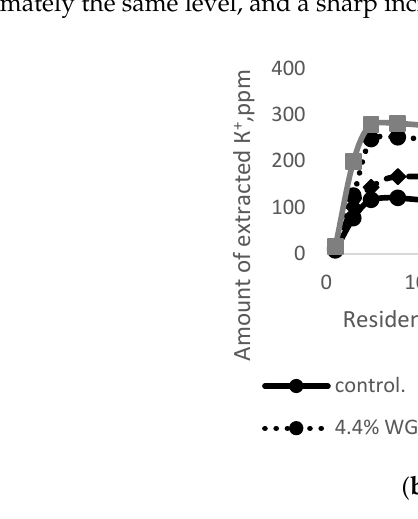
Figure 2. Dependence of the amount of extracted alkali cations on the amount of addition of sodium WG and residence time in the water: ( a ) Na + ; ( b ) K + .